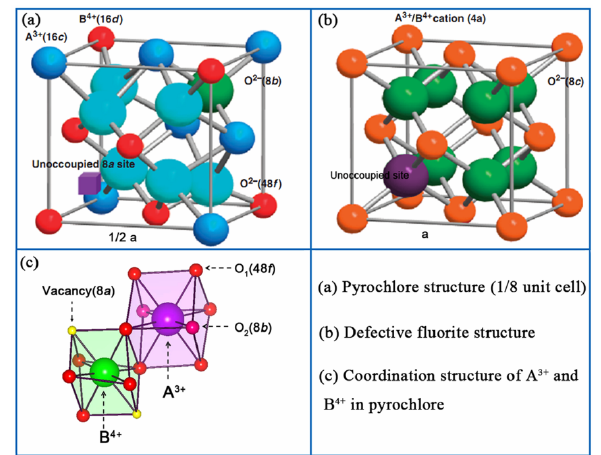
Fig. 1 Crystal structures of pyrochlore and defective fl uorite: (a) one-eighth of unit cell of pyrochlore structure; (b) defective fl uorite structure; (c) coordination structure of A 3+ and B 4+ in pyrochlore. Reproduced with permission from Ref. [56], © University of Chinese Academy of Sciences